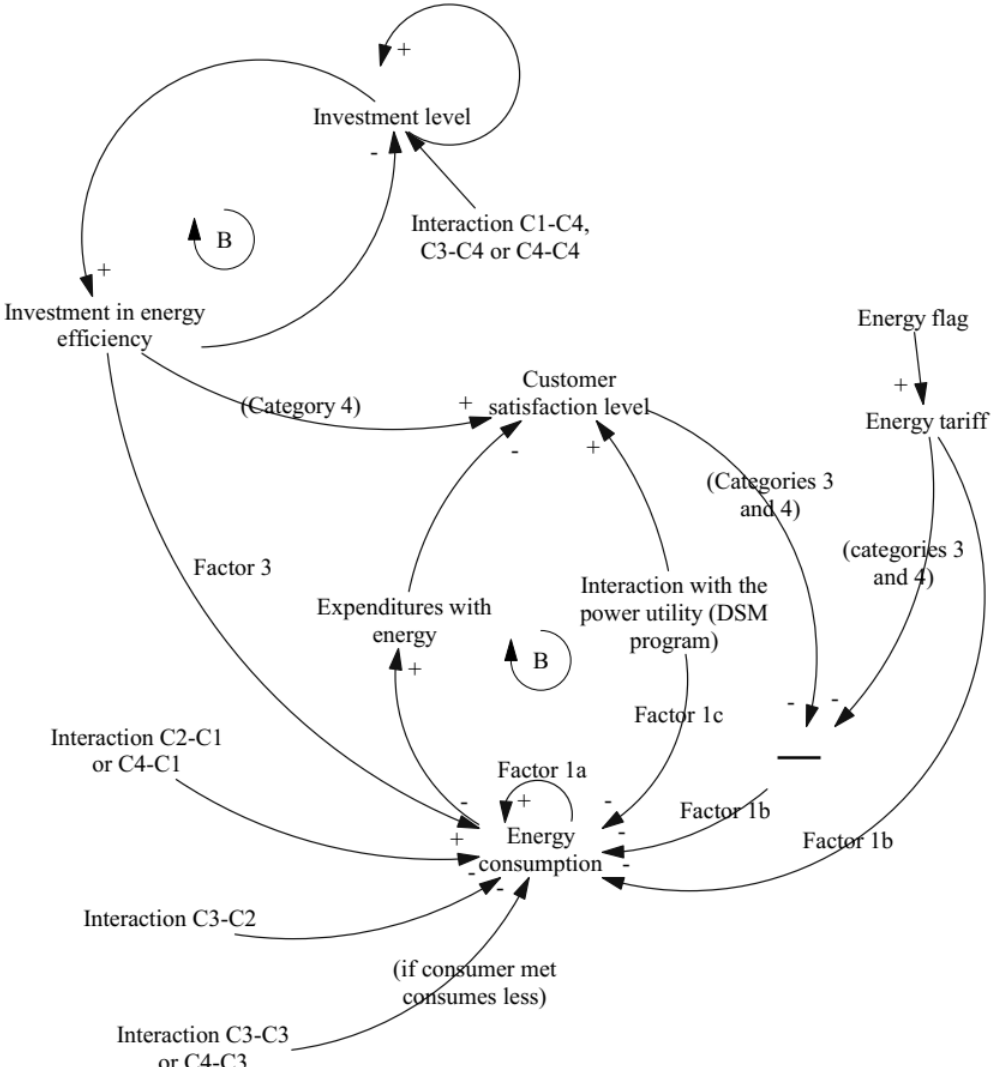
Figure 1. Causal loop diagram.